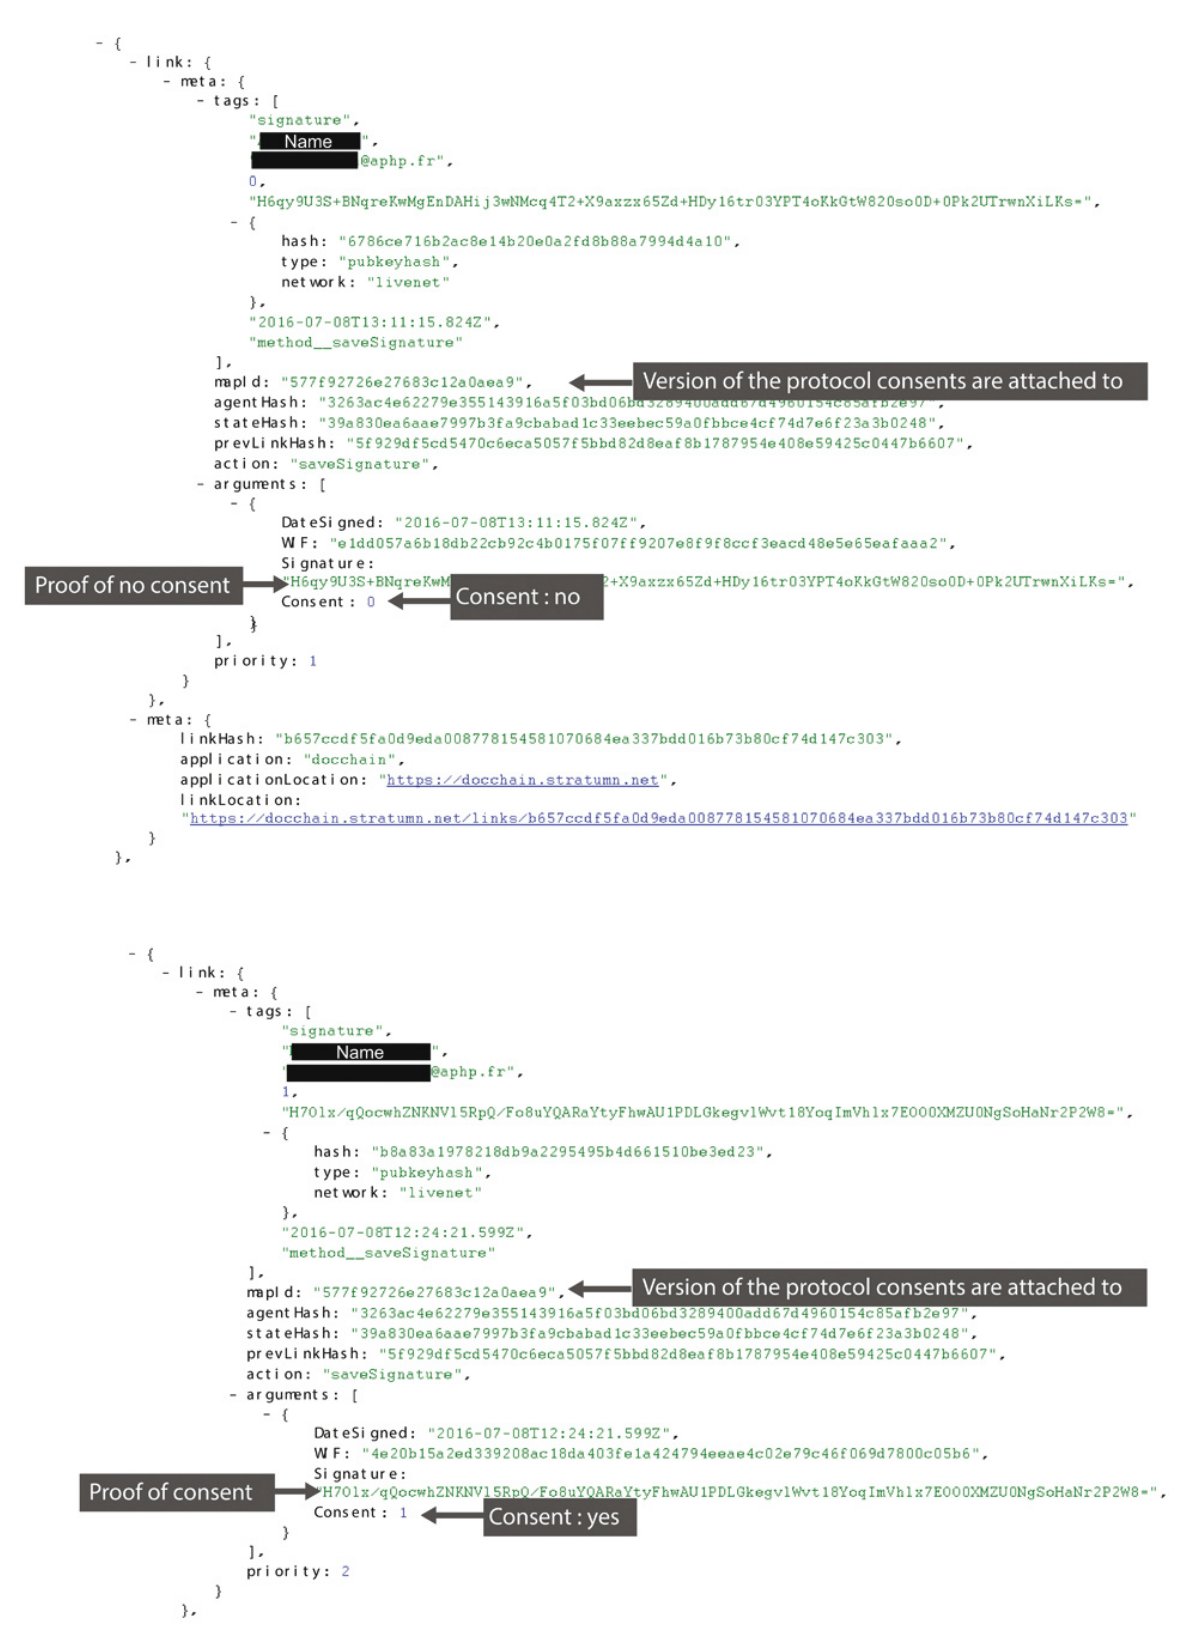
Figure 6. Consent collection master document: consent status bound to protocol revision versions.